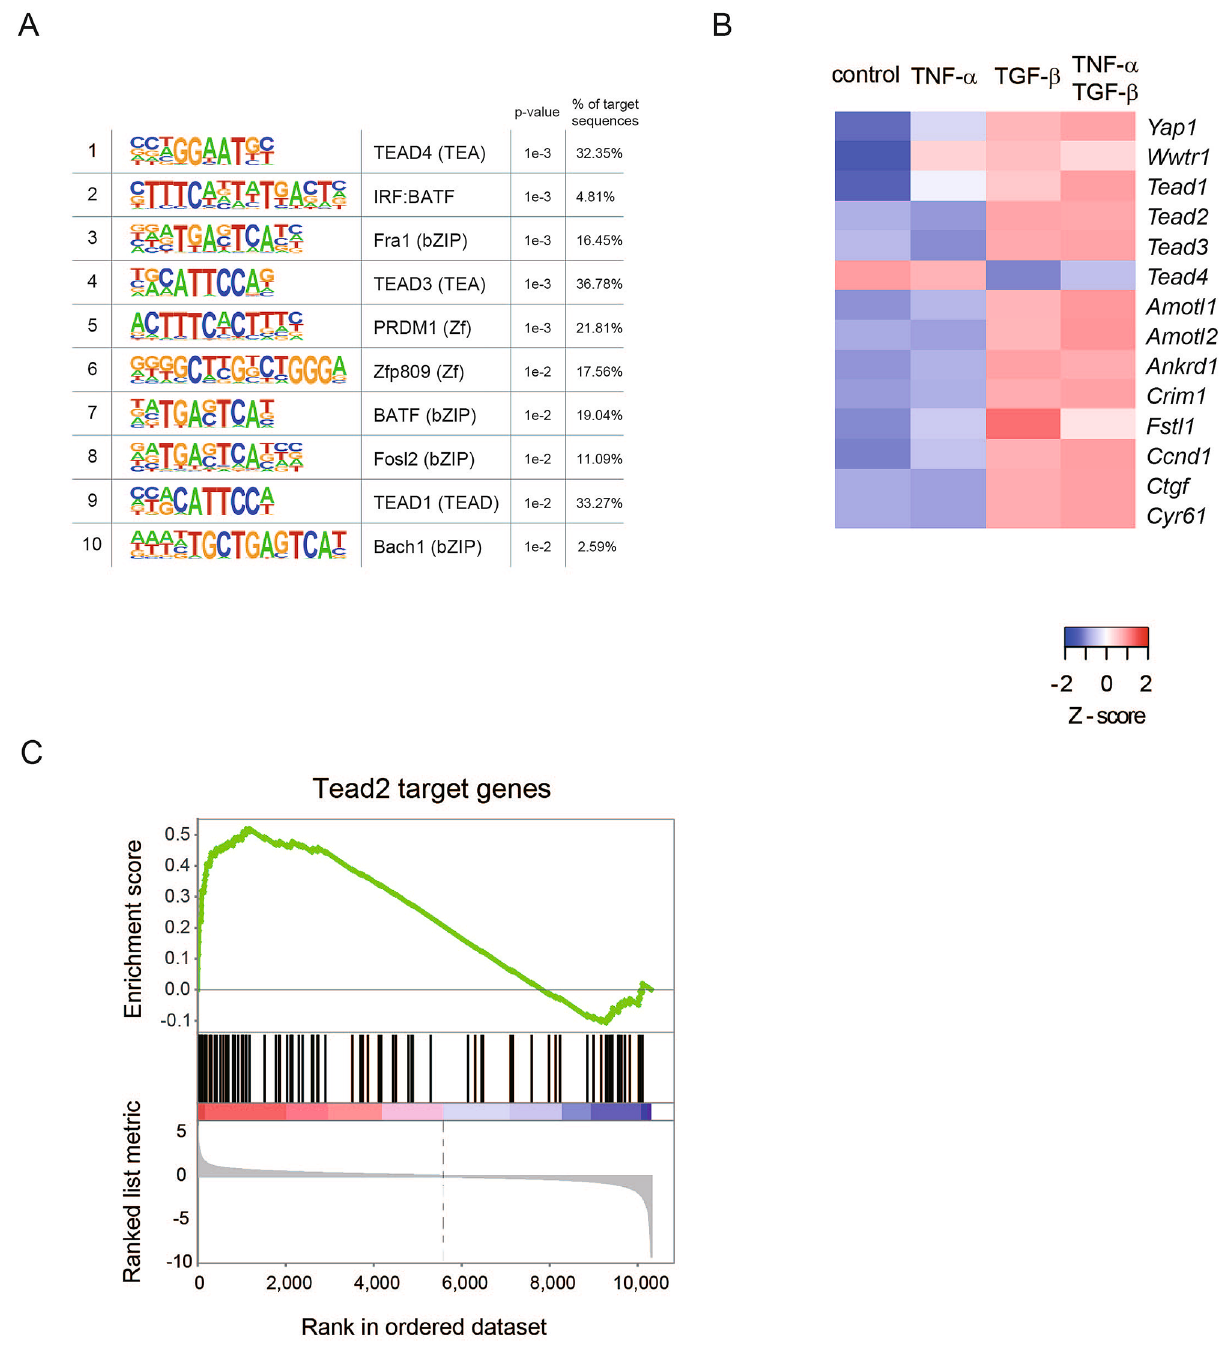
Figure 3. TGF-β-mediated EMT is accompanied by enhanced activity of Tead transcription factors. ( A ) Three known recognition sequences for TEAD transcription factors were among top 10 enriched motifs at the promoters of genes induced by TGF-β. Genes without changes upon TGF-β treatment were used as backgrounds. Percentage of genes that have the indicated motif is shown. ( B ) Heatmap indicates relative expression levels of Yap/Taz signaling components (Yap1, Wwtr1, Tead1, Tead2, Tead3, and Tead4) and Yap/Taz target genes (Amotl1, Amotl2, Crim1, Fstl1, Ccnd1, Ctgf, and Cyr61). CMT64 cells were treated with 5 ng/ml of TGF-β and/or 10 ng/ml TNF-α for 24 h. For the indicated genes, z-scores were calculated from RPKM values obtained by RNA-seq analysis. ( C ) Gene set enrichment analysis was performed to examine the enrichment of Tead2 target gene signature in TGF-β-induced genes in CMT64